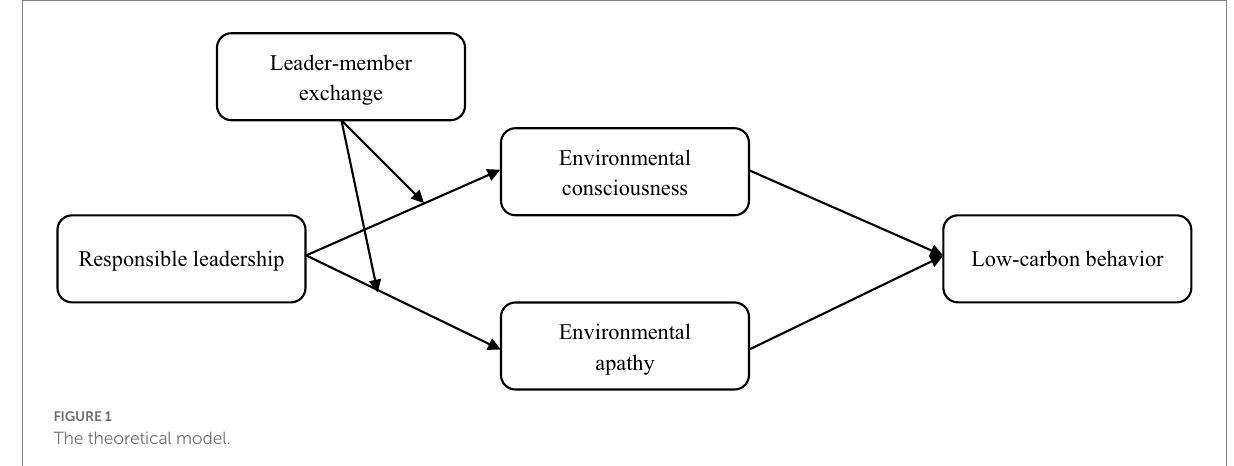
FIGURE 1 The theoretical